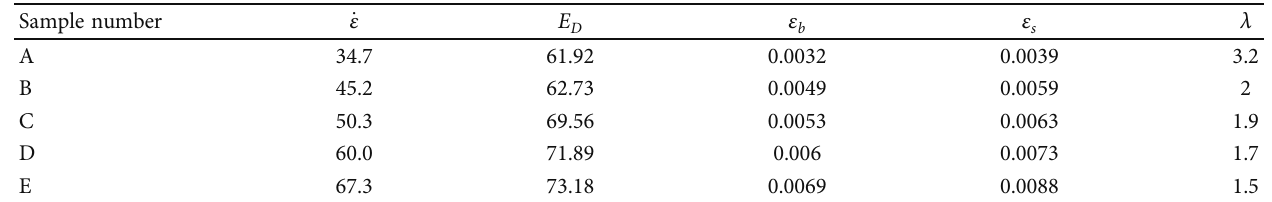
Figure 9: Comparison between stress-strain measured and fi tting curves: (a) 34.72s -1 , (b) 45.22 s -1 , (c) 50.34s -1 , (d) 59.97s -1 , (e) 67.32s -1 Table 1: Correlation between model parameters and test data.